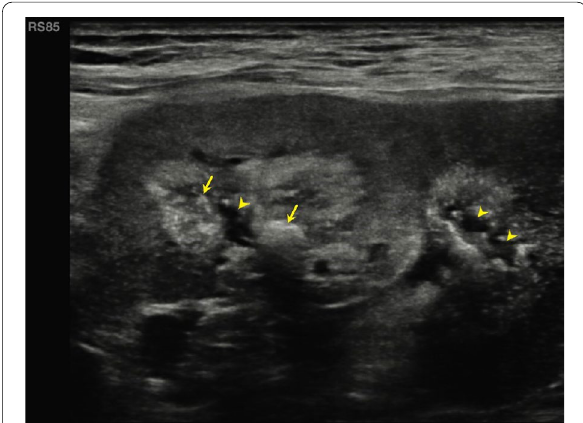
Fig. 2 Philips EPIQ, linear transductor, B-mode, frequency 5–12 MHz, right lower abdomen quadrant, cranial kidney: with a highly detailed linear probe it is possible to appreciate in the cranial kidney,